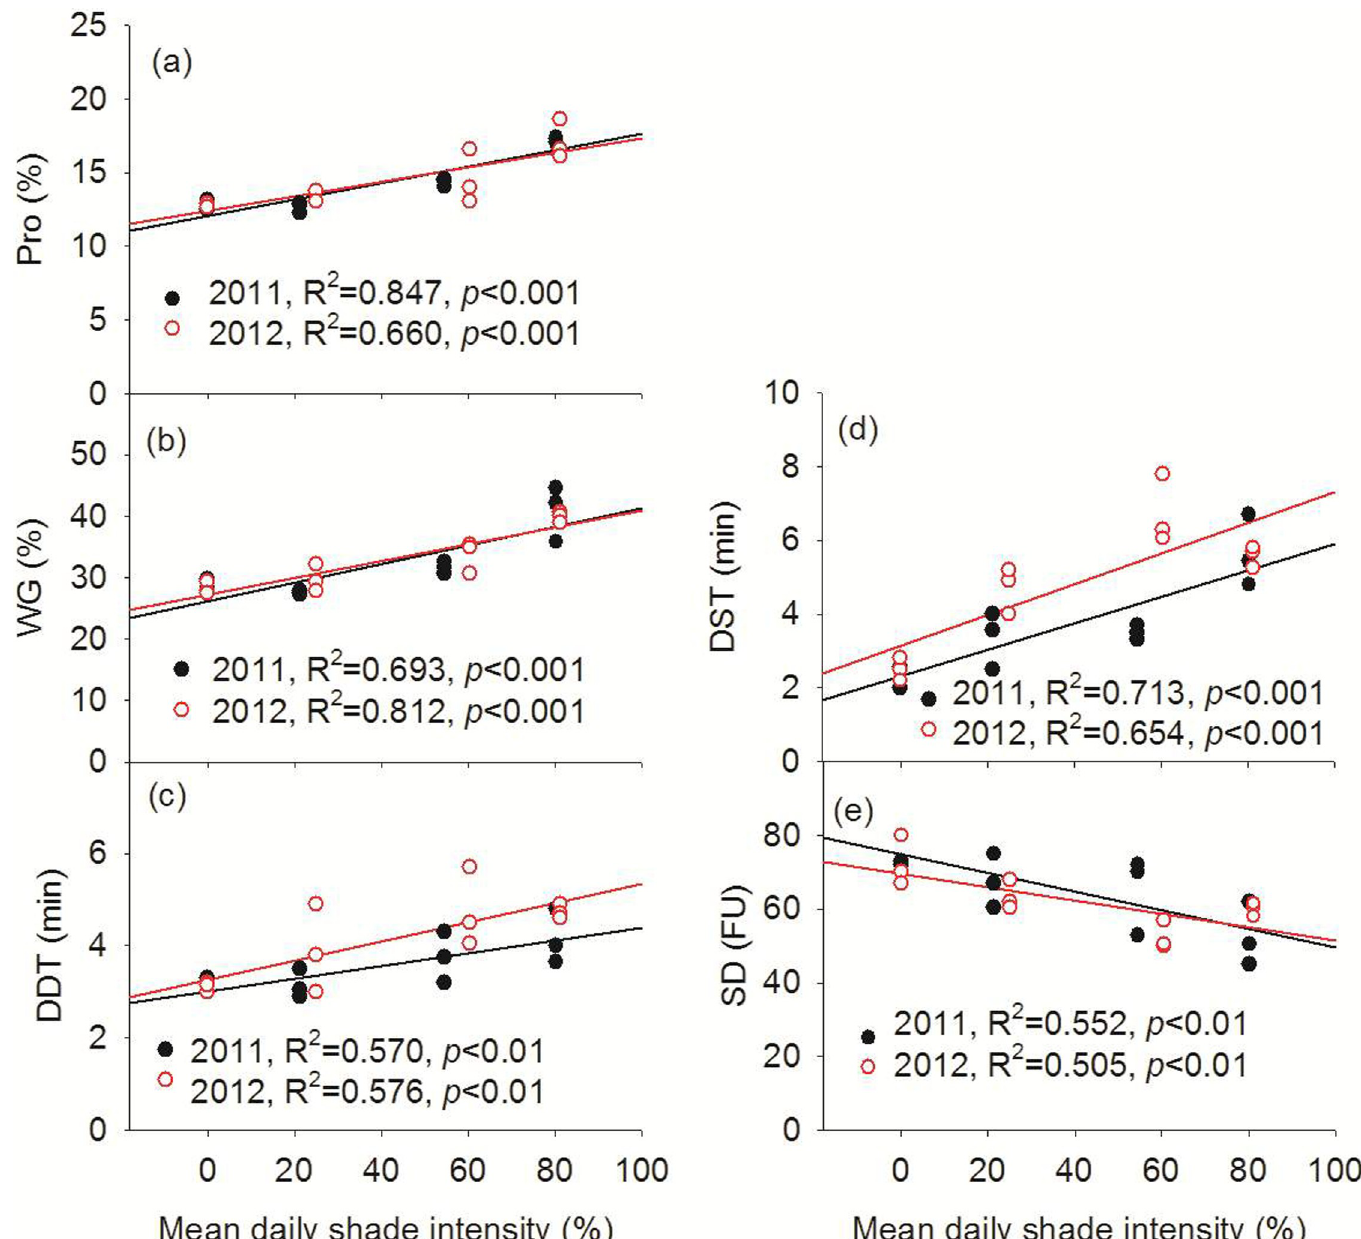
Fig 7. Relationships between grain quality with mean daily shade intensity of wheat in 2011 and 2012. Pro: Protein content; WG: Wet gluten content; DDT: Dough development time; DST: Dough stability time; SD: Softening degree.